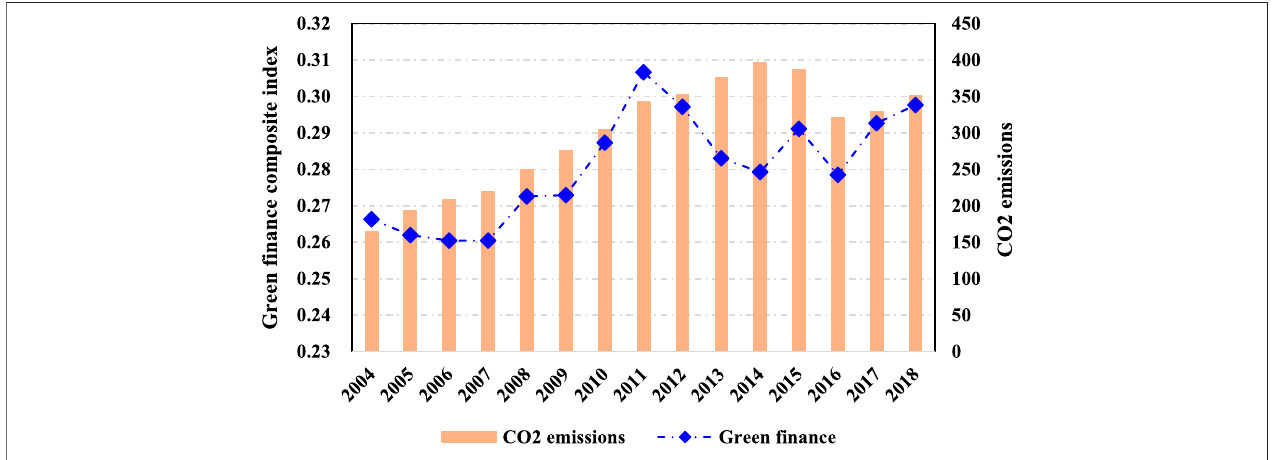
FIGURE 1 | Time trend chart of the average values of CO 2 emissions and green fi